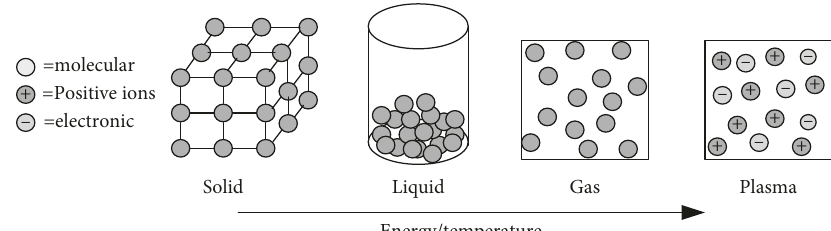
Figure 1: Schematic diagram of the plasma formation